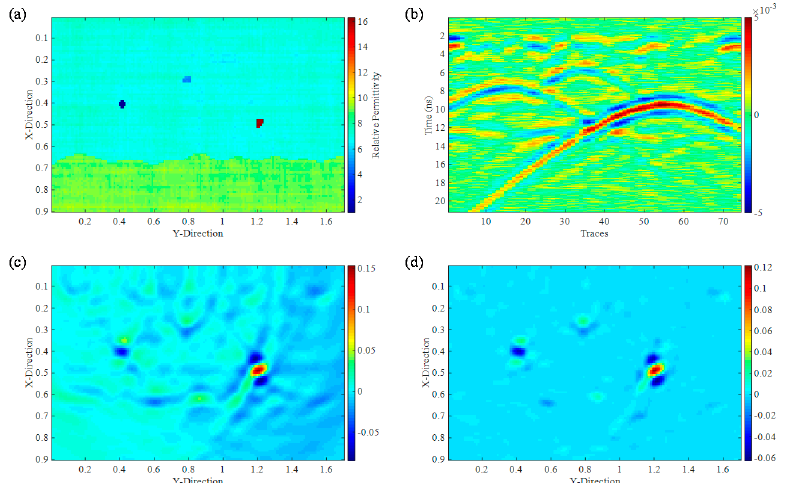
Figure 5. The model of defects with different reflectance. ( a ) the distribution of relative permittivity; ( b ) 2-D GPR profile; ( c ) back projection imaging; ( d ) RPCA anomaly extraction.